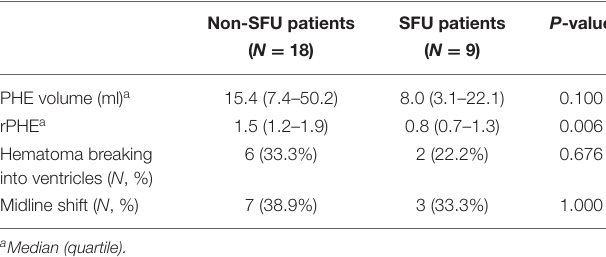
FIGURE 2 | Measurements of hematoma and perihematomal edema using 3D slicer software package. Two patients with similar ICH volumes but different PHE volumes were shown in this figure. Top panel: A patient with ICH from non-SFU group. (A) original image of head CT. (B) hematoma (5.0 ml) marked with pink. (C) PHE (6.7 ml) marked with blue. Bottom panel: A patient with ICH from SFU group. (D) original image of head CT. (E) hematoma(4.9ml) marked with pink. (F) PHE (4.2 ml) marked with blue. ICH, intracerebral hemorrhage; PHE, perihematomal edema. TABLE 4 | Analysis of the associations between pretreatment of sulfonylureas TABLE 2 | Imaging characteristics on admission of sulfonylureas (SFU) and use, perihematomal edema (PHE) volume and rPHE in sulfonylureas (SFU) and non-SFU patients. non-SFU